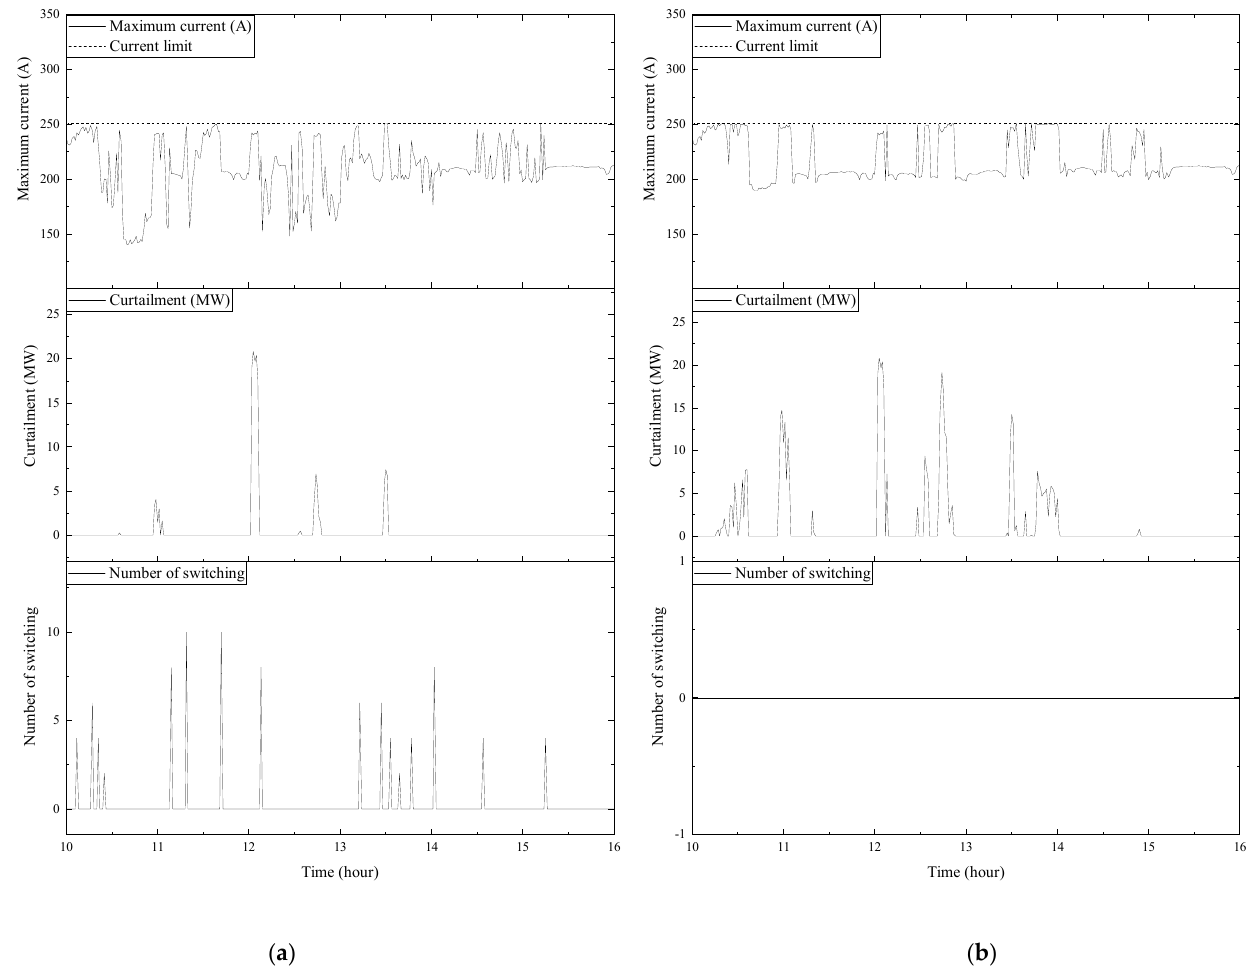
Figure 16. Curtailment and the number of switching operations: ( a ) network reconfiguration applied first; ( b ) with curtailment only.